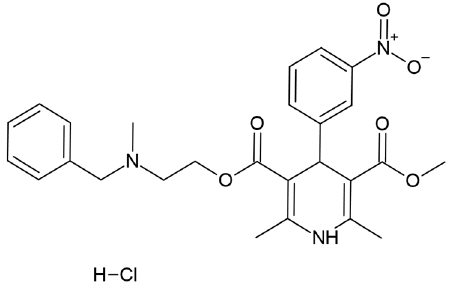
Figure 1. Chemical structure of nicardipine hydrochloride.